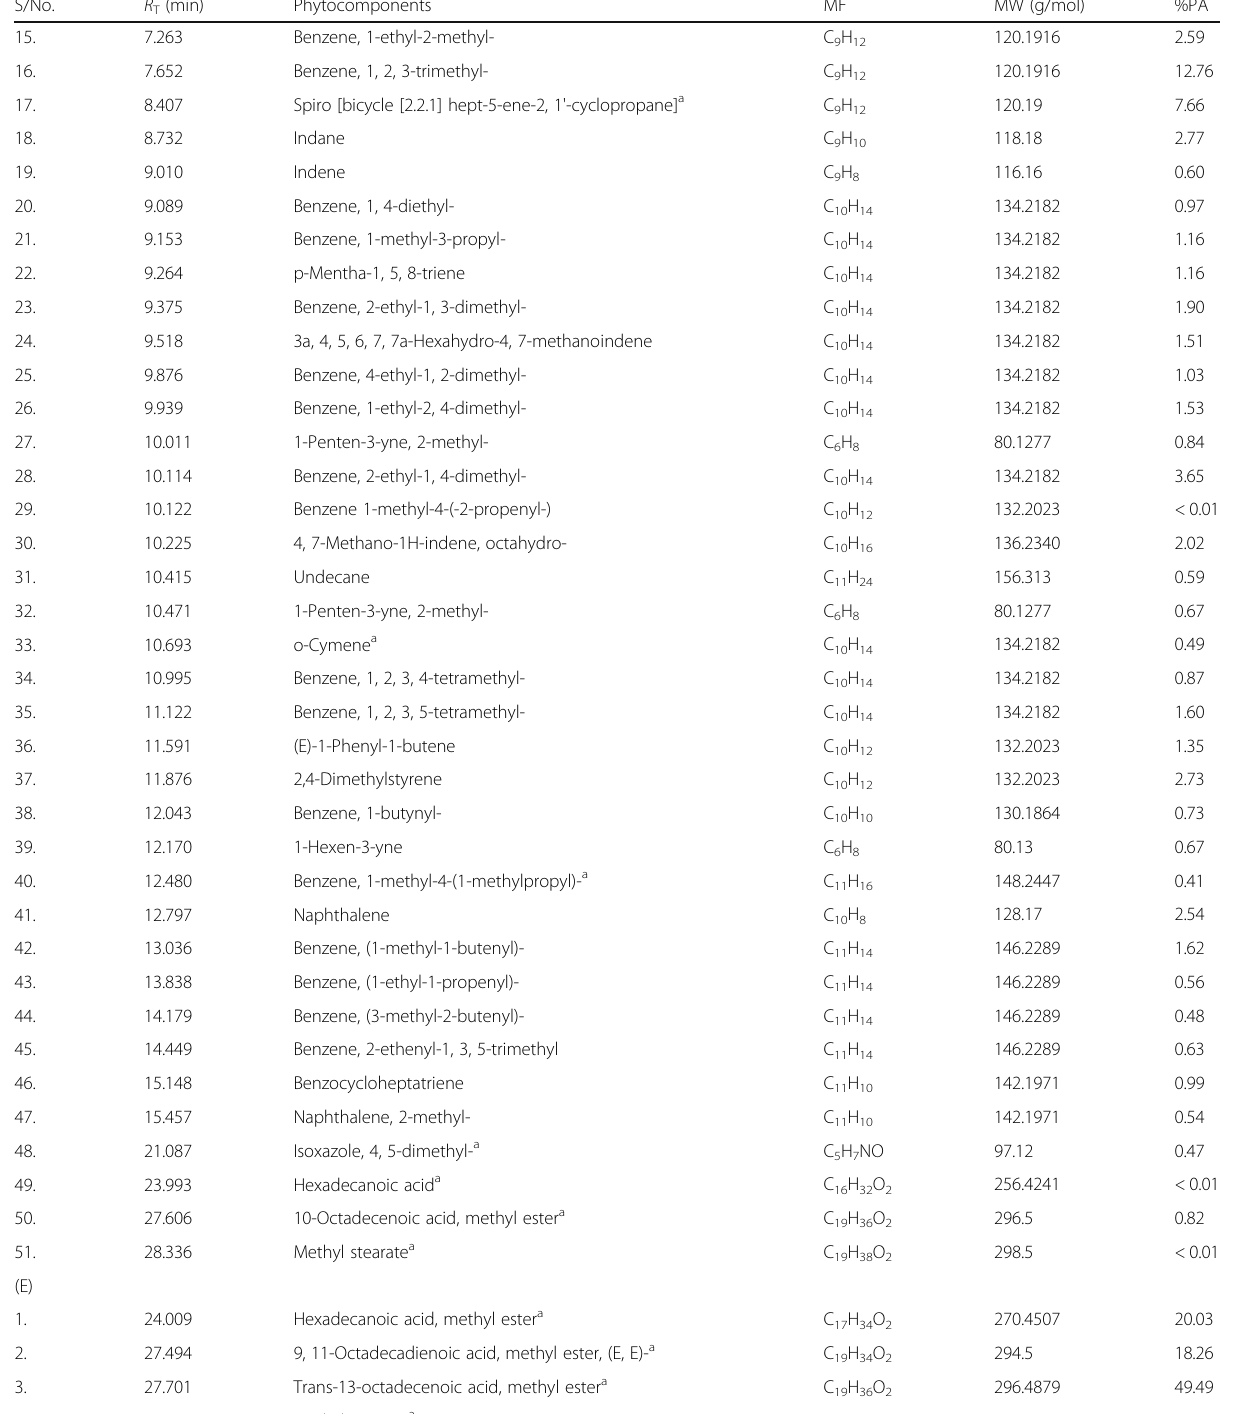
Table 2 Phytocomponents of (A) petroleum ether extract of A . occidentale , (B) ethylacetate extract of A . occidentale , (C) n -hexane extract of P . guajava , (D) petroleum ether extract of T . catappa , (E) ethylacetate extract of T . catappa (Continued)